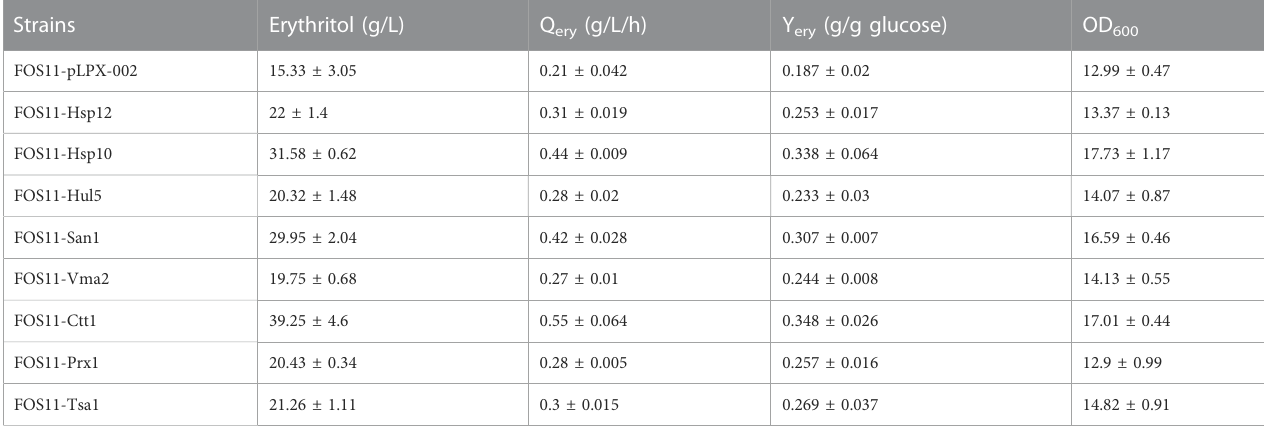
TABLE 2 Summary of fermentation pro fi les of engineered and control strains at 35 ° C.